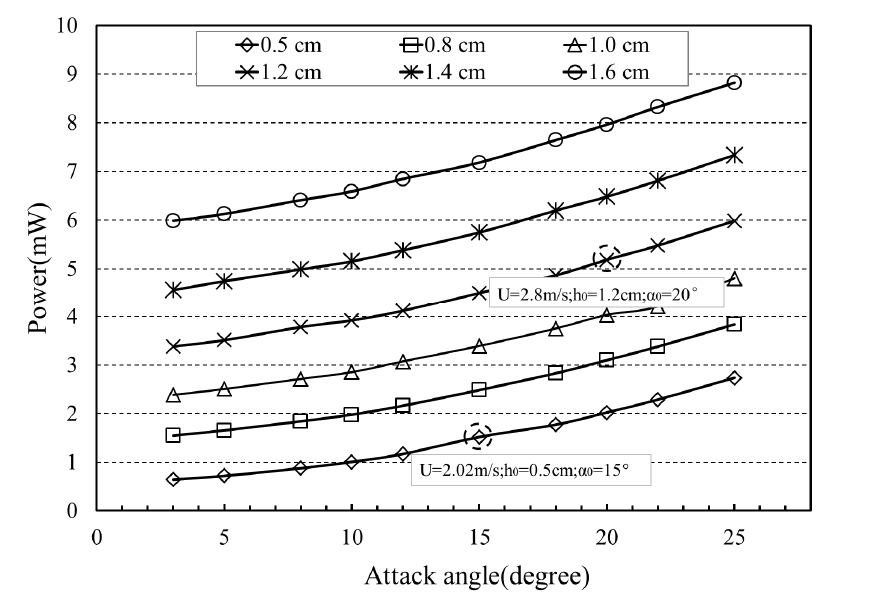
= 15° when U = 2.02 m/s; amplitude h 0